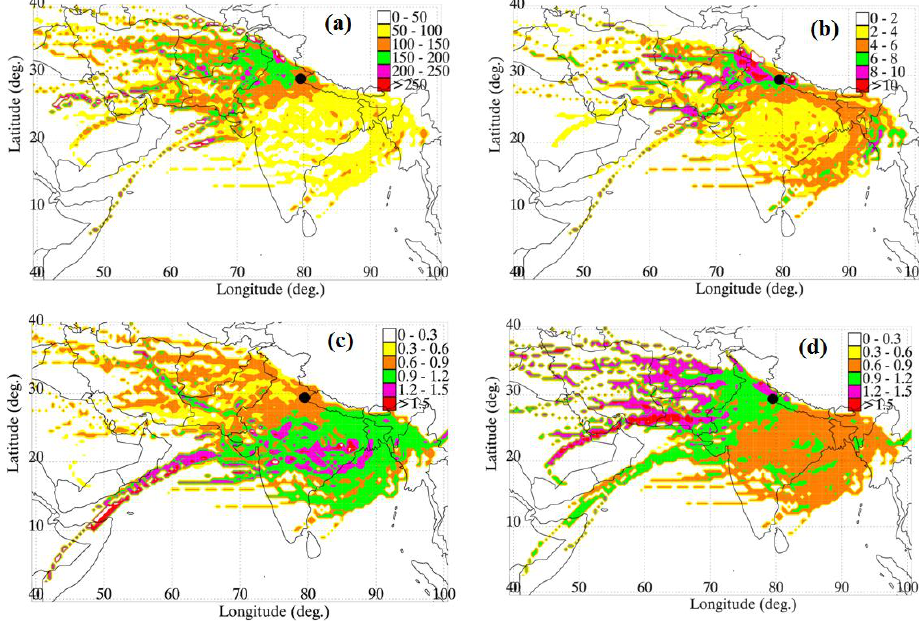
Figure 10. Concentrated weighted trajectory maps using 5-day backward trajectories ending at Nainital at 500m for scattering (a) , absorption (b) coefficients, SAE (c) and AAE (d) for D 10µm